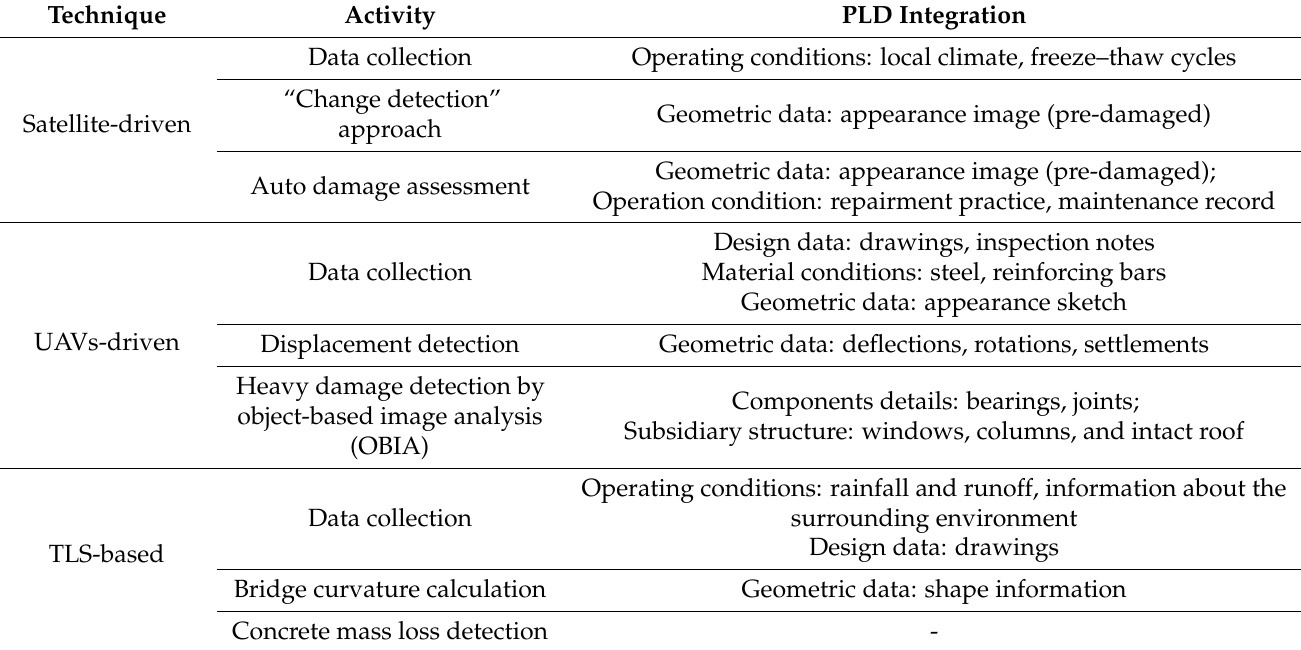
Table 4. Integration of contactless damage assessment techniques and